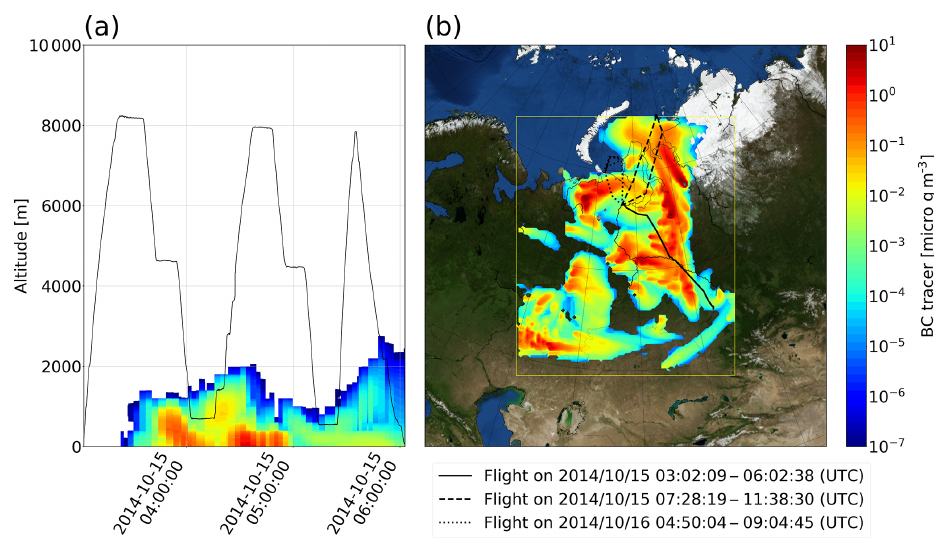
Figure 25. Simulated concentrations of BC tracer with a 5d lifetime (µgm − 3 ) (a) along the YAK flight on 15 October 2014 (flight altitude also given, white line) and (b) at the surface at 05:00UTC on 15 October 2014; flight tracks are also shown. BC tracer concentrations are normalized to the total BC emissions from Huang et al. (2015) over the model domain and emitted based on annual mean flaring locations using VIIRS data.